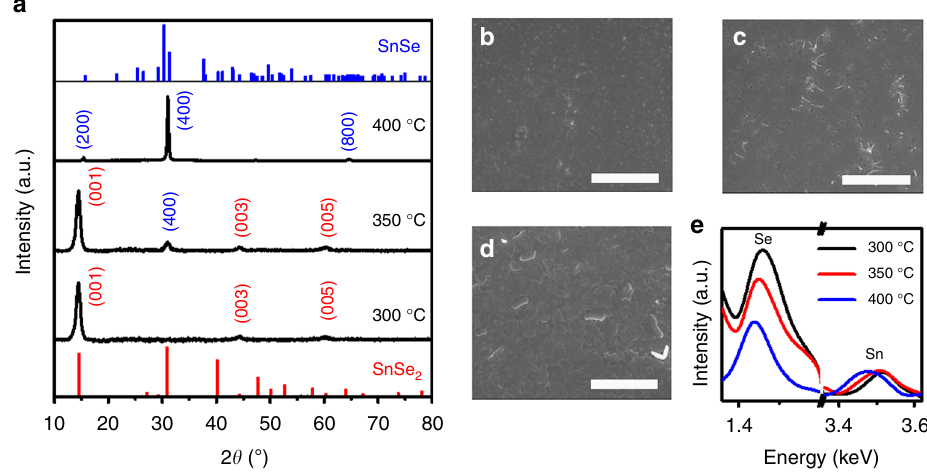
Fig. 3 Composition change-driven texturing. a XRD patterns of the SnSe thin fi lms upon heating. At 300 °C, only (00 l ) peaks of SnSe 2 were observed in the XRD pattern. At higher temperatures, these peaks progressively disappeared and the ( h 00) peaks of SnSe were exclusively detected at 400 °C. Vertical lines in panel a indicate the orthorhombic SnSe (blue, JCPDS 32 – 1382) and the hexagonal SnSe 2 phase (red, JCPDS 89 – 2939). b – d SEM images of the SnSe thin fi lms at b 300 °C, c 350 °C, and d 400 °C. show progressive microstructural changes during the transition from SnSe 2 to SnSe. Scale bar, 5 μ m. e EDS spectra of the SnSe thin fi lms upon heating shows the decreasing Se content, compared with the normalized Sn content